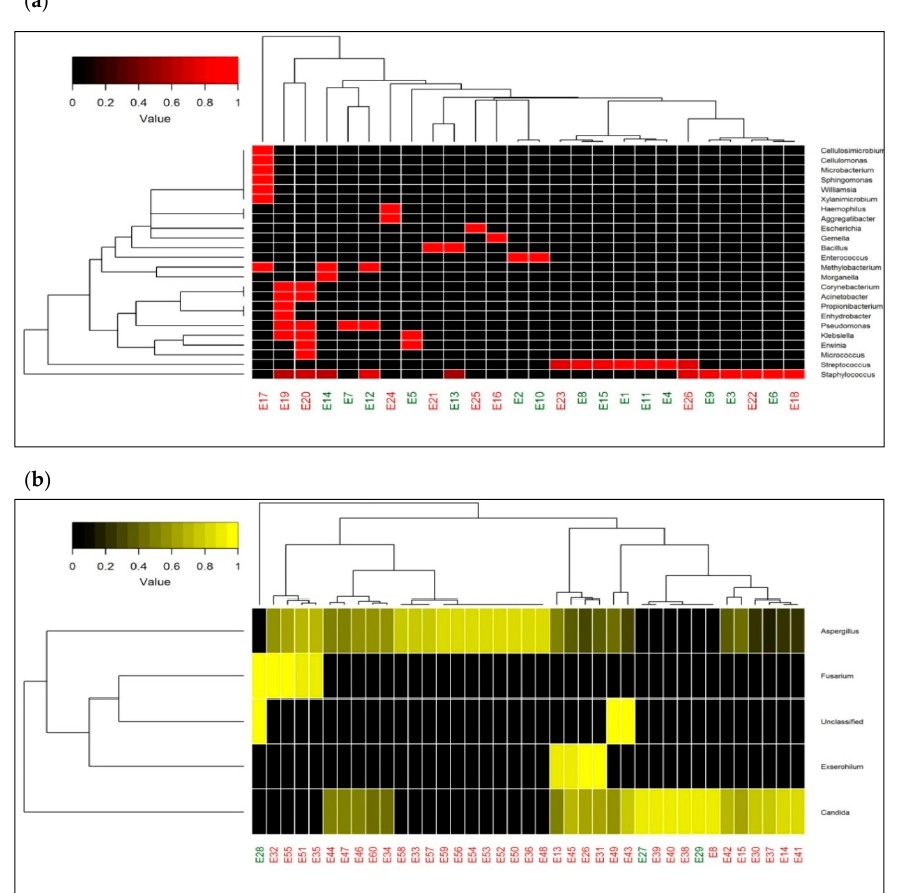
Figure 2. Taxonomic heatmap representing microbial abundance in patient samples. ( a ) Heatmap depicting bacterial diversity and its relative abundance from both culture-positive and culture-negative vitreous fluids of patients with endophthalmitis clinically. ( b ) Heatmap depicting fungal abundances in vitreous of patients with both culture-positive and culture-negative endophthalmitis. The color legend on the top left side indicates the average relative abundances of these genera in each sample.